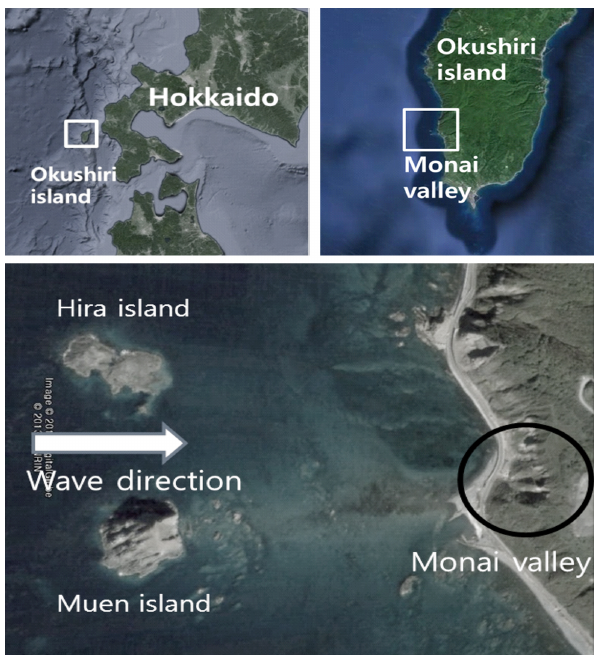
Figure 1. Location map of Monai Valley showing Hira and Muen islands off the western coast of Okushiri Island, Hokkaido, Japan (Google